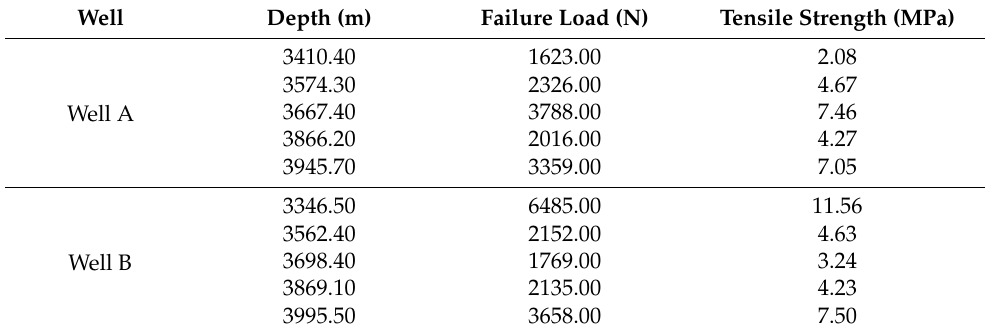
Table 1. Test results for tensile strength of